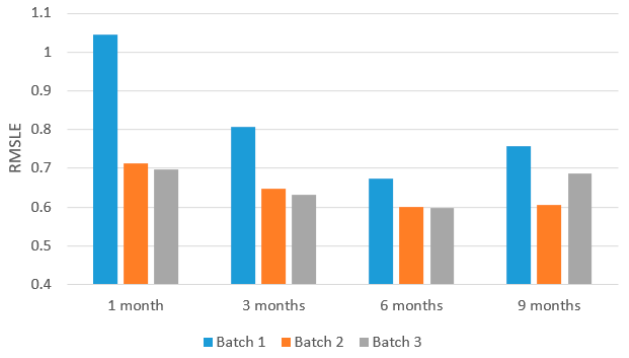
Figure 13. Different periods of prediction for Drop-off.